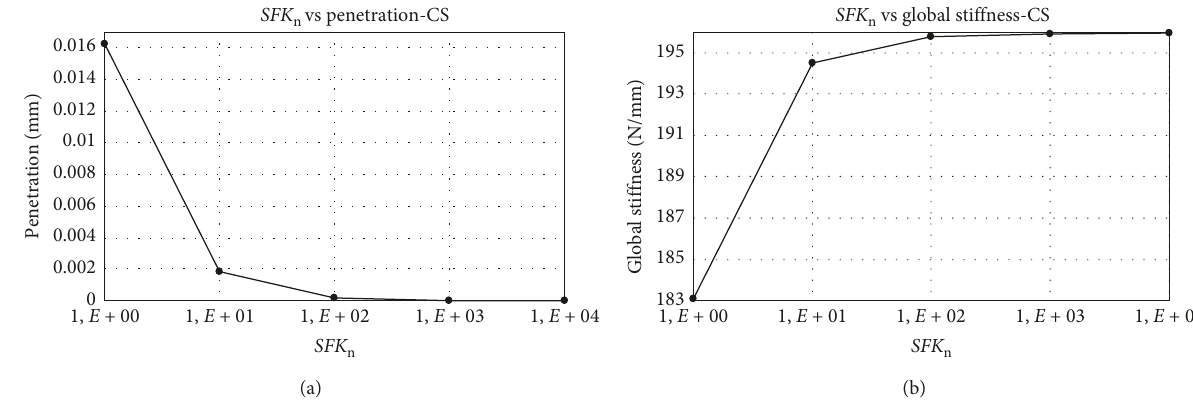
Figure 4: Penetration (a) and global stiffness (b) as a function of k